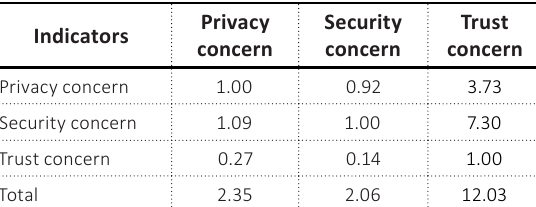
Table 3. Pairwise comparison matrix of various aspects of security risk